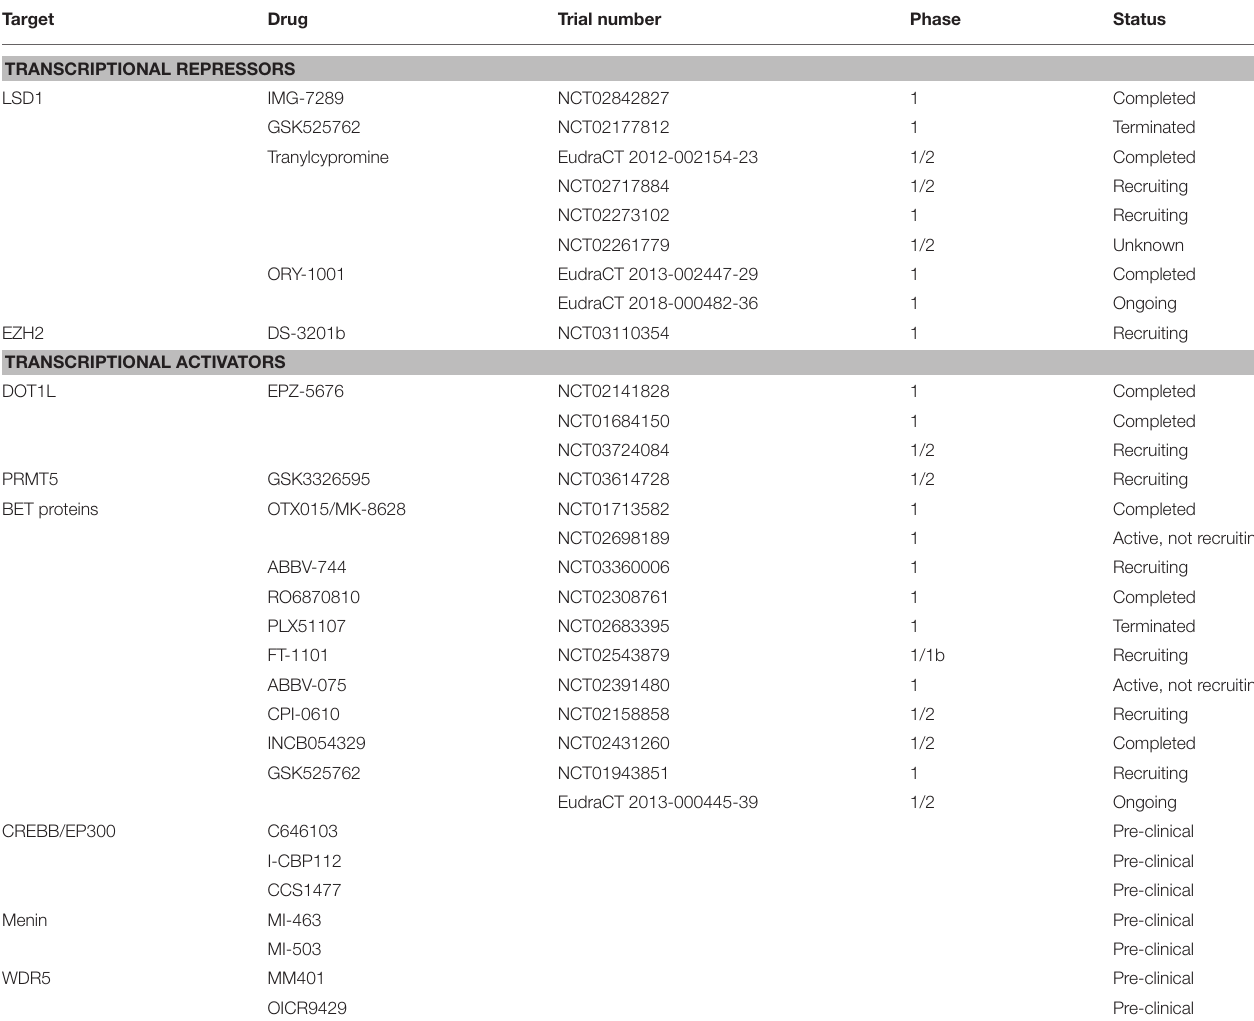
TABLE 1 | Key clinical trials of novel epigenetic therapies in AML (March